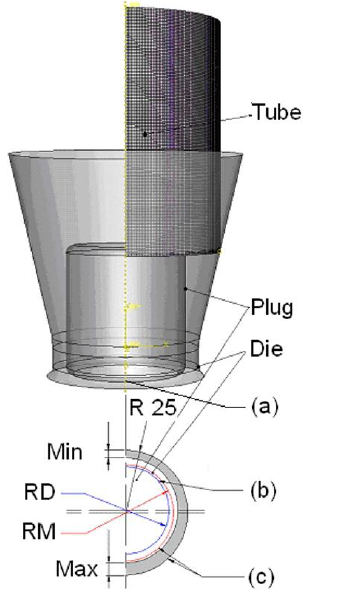
Figure 4. Assembly of the model: ( a ) coaxial definition, plug and inside surface of